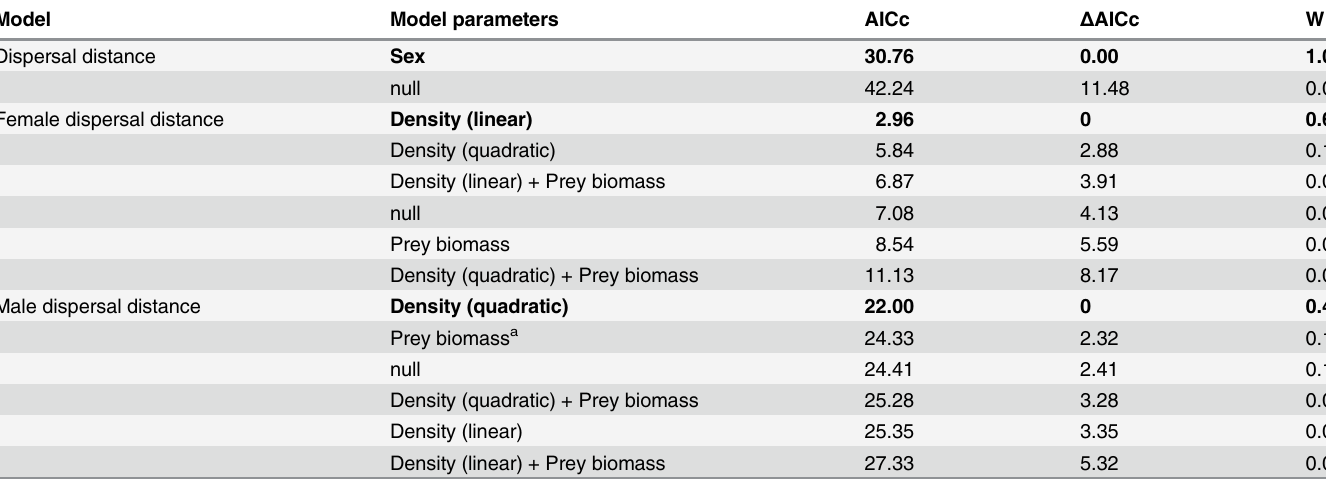
Table 3. A priori linear models exploring the effect of sex, time as a proxy for population density and prey biomass density on dispersal distance in subadult leopards in Phinda Game Reserve, South Africa, 2002 – 2012.